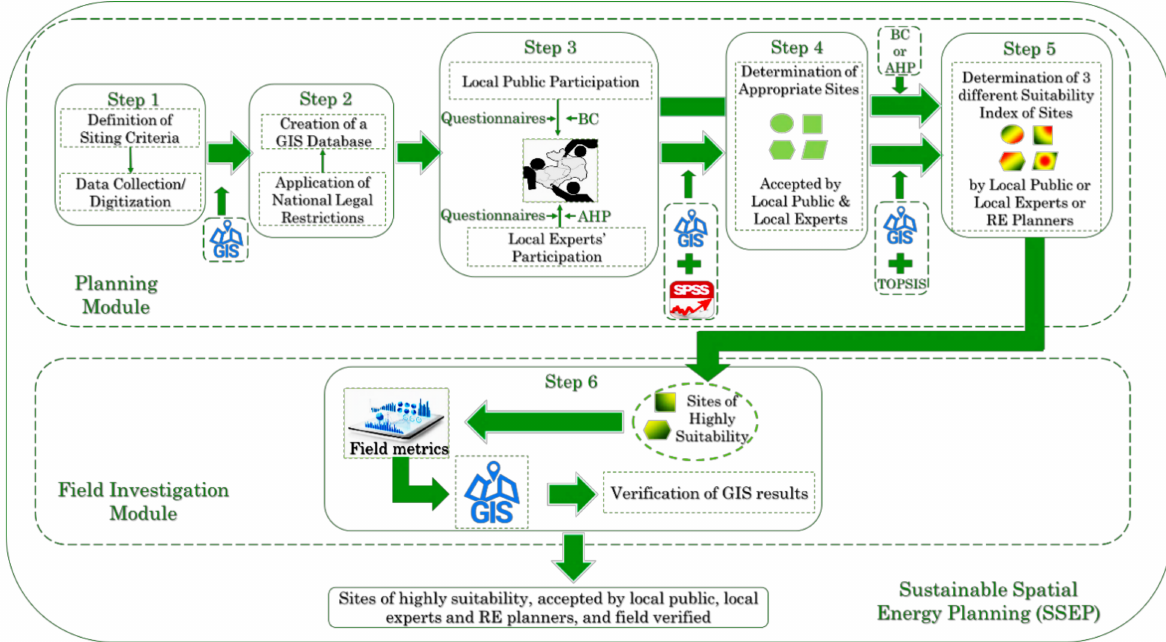
Figure 1. Proposed Sustainable Spatial Energy Planning (SSEP) framework for large-scale Wind Farms’ (WFs’) and Photovoltaic Farms’ (PVFs’) site-selection in